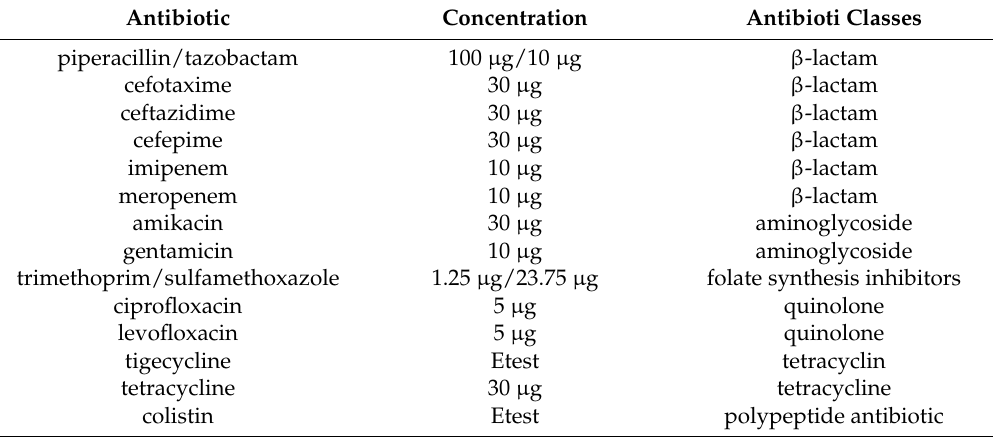
Table 2. List of tested antibiotics, concentration on the disc (Sensi-DiscTM paper discs, BD, Vienna, Austria) or Etest ® (Biomerieux) and antibiotic classes.